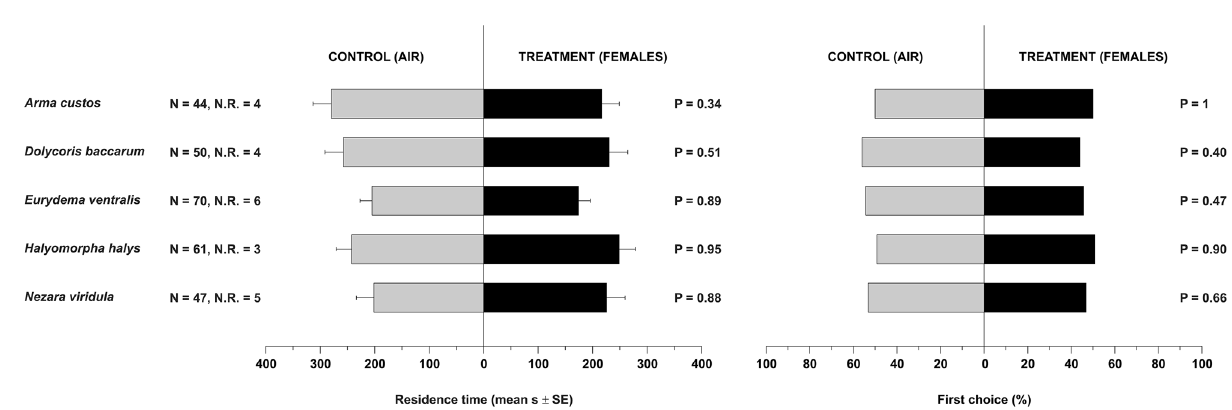
Figure 1. Residence time (means ± SE) and first choice (%) of Trissolcus mitsukurii females in Y-tube olfactometer exposed to odours from stink bug–plant systems. Treatments consisted of volatiles from soybean plants bearing an egg mass of Arma custos , Dolycoris baccarum , Halyomorpha halys , or Nezara viridula , or volatiles from cauliflower plants bearing an egg mass of Eurydema ventralis . Control consisted of a clean soybean or cauliflower plant. N number of responding insects. N.R. number of not-responding insects (discarded from the analysis). Planned comparisons were tested within GLM with Gaussian error distribution (residence time) or with binomial error distribution (first choice).